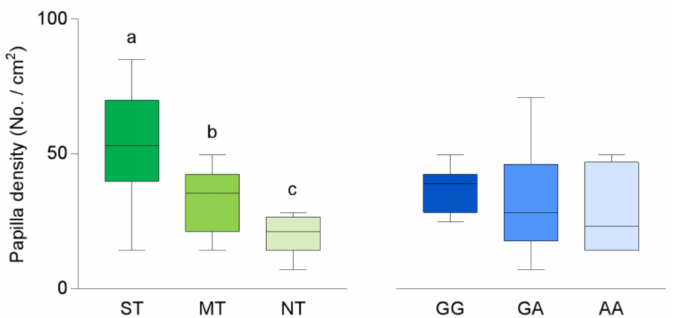
Figure 3. Box-and-whisker plots showing the minimum, first quartile, median, third quartile, and maximum of each set of density of fungiform papillae data in super-tasters (ST; n = 10), medium-tasters (MT; n = 13) and non-tasters (NT; n =12) and in volunteers with genotypes GG ( n = 9), GA ( n = 20) and AA ( n = 6) of CD36 . Different letters indicate a significant difference ( p ≤ 0.032; Duncan’s test subsequent one-way ANOVA).